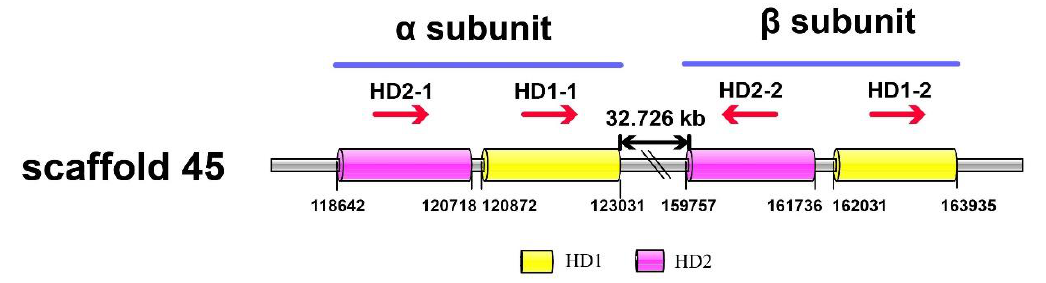
Figure 6. The mating-type structure of 14-8. The blue lines indicate the mating-type locus, the red arrows indicate the transcriptional direction of the genes, and the gray bar represents the region of scaffold45 that contains the mating-type genes. The numbers below are the positions of the two ends of the mating-type genes on scaffold45. The gap between the two subunits is 32.726 kb.